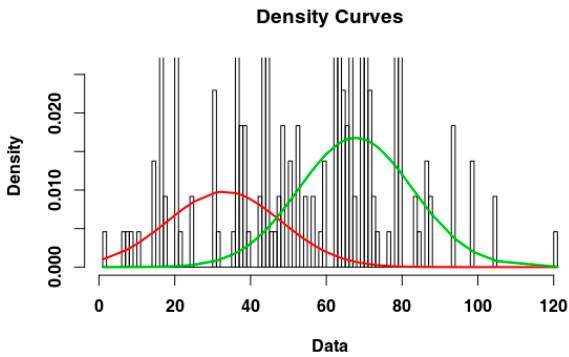
Figure 2. Gaussian Mixed Models on Belgium data set, where we already removed the first 60 days.